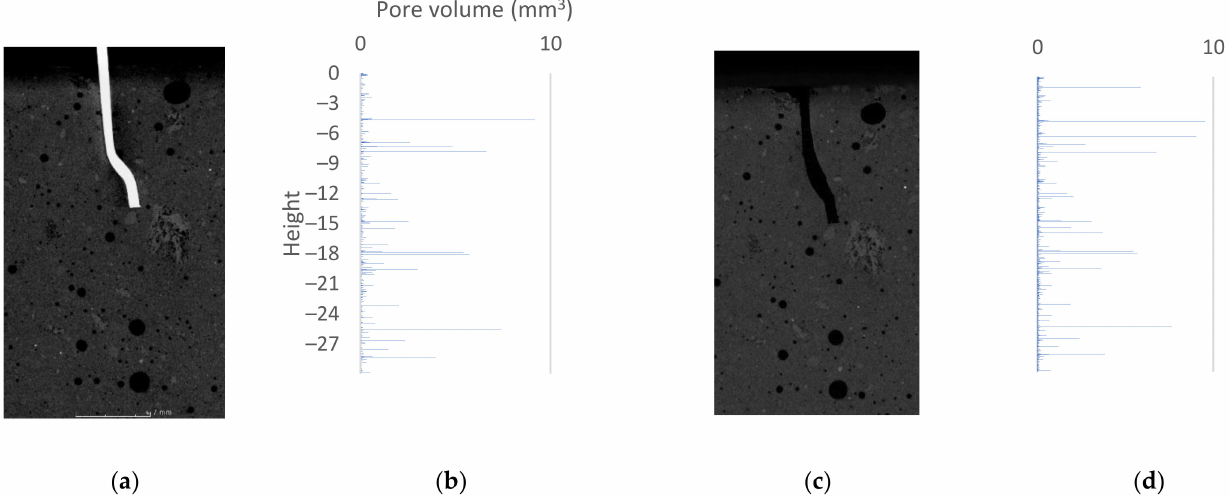
Figure 7. The 15 mm sample: ( a ) 2D cross-section before fiber pullout; ( b ) 3D porosity analysis—plot of pore volume against height in sample before fiber pullout; ( c ) 2D cross-section after fiber pullout; ( d ) 3D porosity analysis—plot of pore volume against height in sample after fiber